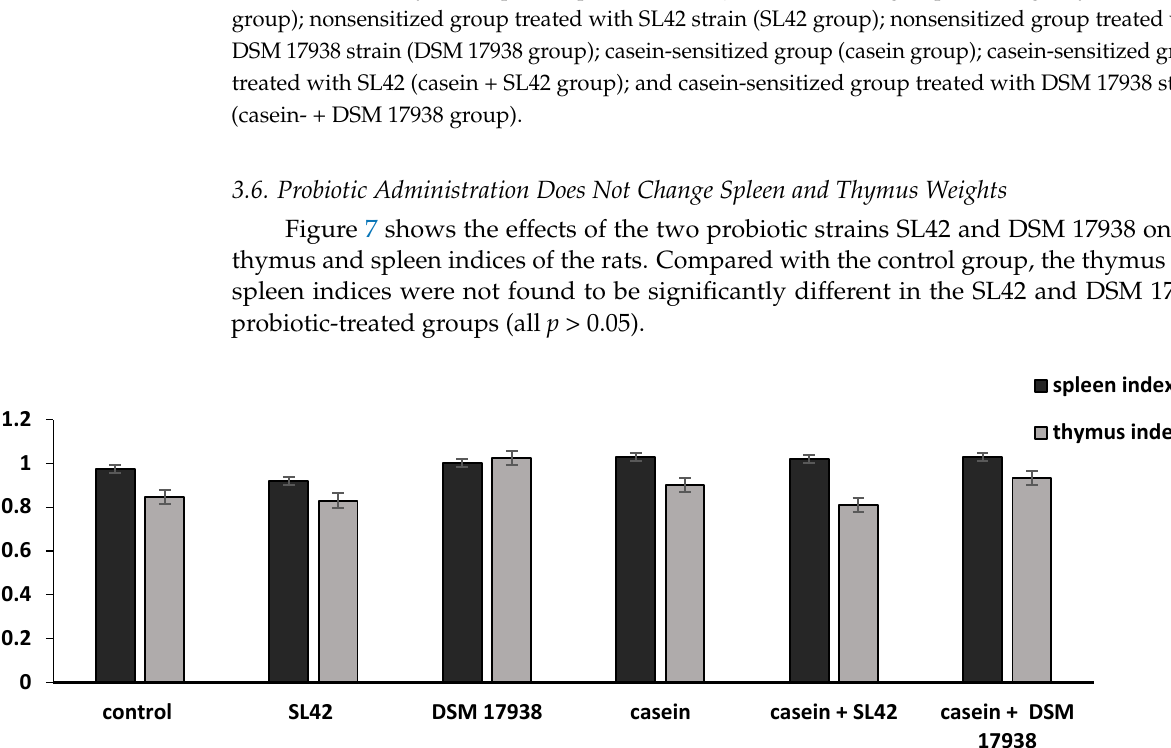
Figure 6. Bacteria numbers as determined by plating technique (n = 8 rats/ group). Lactic acid bac- teria ( a ), Clostridia species ( b ). Wistar rats were sensitized intragastrically by administration of ca- sein without adjuvant. The rats were fed every other day with L. rhamnosus SL42 or L. reuteri DSM 17938 at 1 × 10 8 CFU/mL (feces were collected on the 59th day). The dose volume was 1 mL. The control group was fed with sterilized PBS solution. The data (MRS toen ) are presented as the mean ± SD. Statistical analysis was conducted by using one-way ANOVA with Tukey’s multiple comparisons test. * p < 0.05. Control group receiving only PBS (con- trol group); nonsensitized group treated with SL42 strain (SL42 group); nonsensitized group treated with DSM 17938 strain (DSM 17938 group); casein-sensitized group (casein group); casein-sensi- tized group treated with SL42 (casein + SL42 group); and casein-sensitized group treated with DSM 17938 strain (casein- + DSM 17938 group).